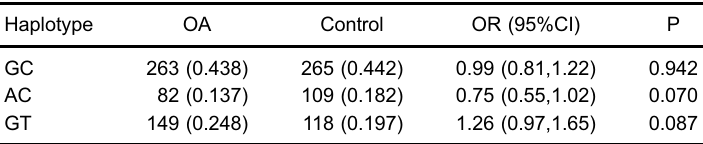
OA: osteoarthritis. Chi-squared test.